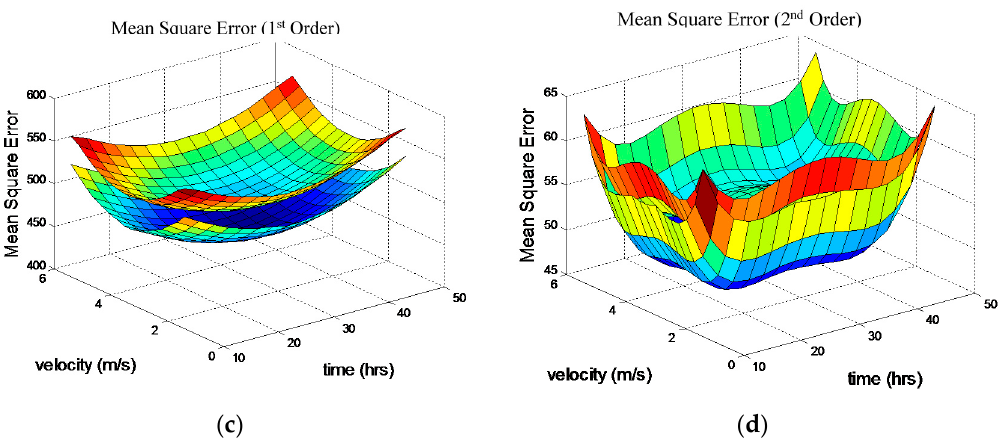
Figure 12. Mass loss versus time and velocity for constant sand concentrations ( s = 0%, 15%, and 30%); ( a ) First-order model; ( b ) Second-order model; ( c ) MSE for the first-order model; ( d ) MSE for the second-order model.